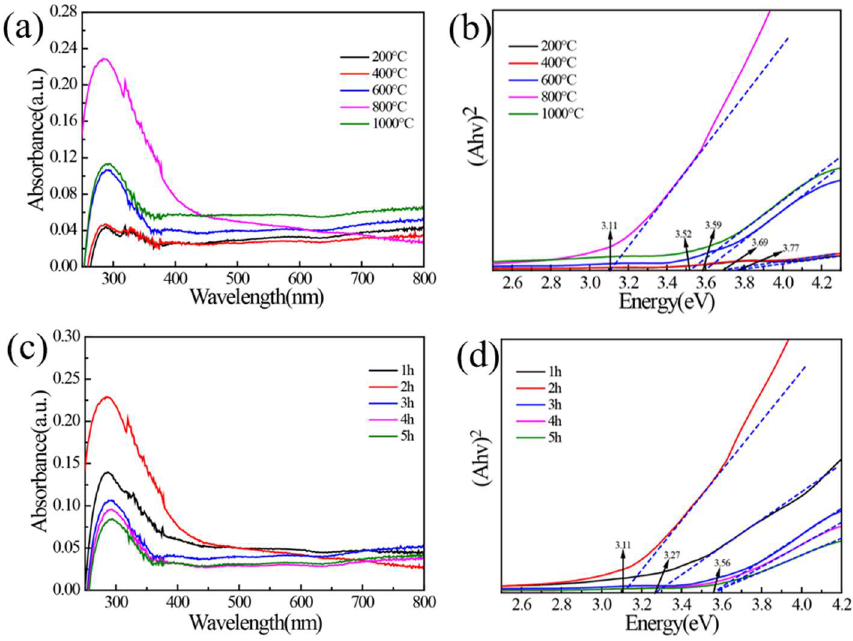
Figure 5. UV-Vis and hv-(Ahv) 2 diagram of HAP at different calcination temperatures ( a , b ), UV-vis and hv-(Ahv) 2 diagram of HAP calcined for different time ( c , d ).